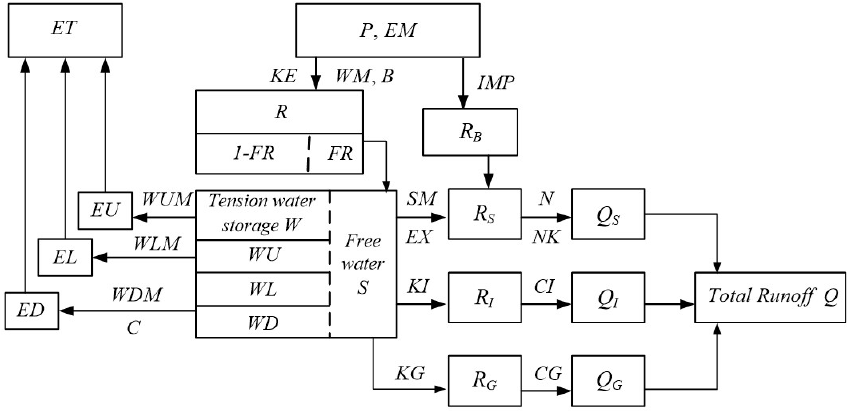
Figure 2. Flow chart of the Xinanjiang model. Table 2. Parameters of the Xinanjiang